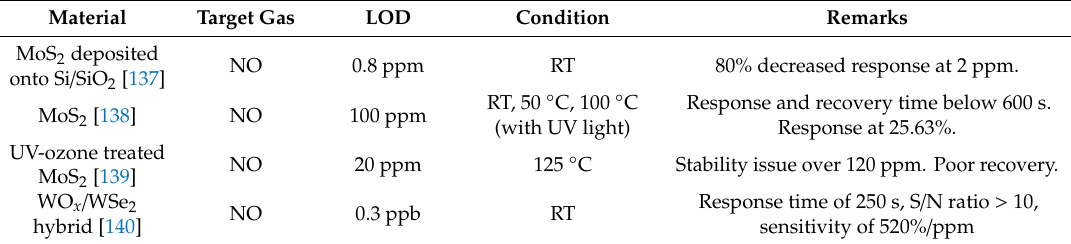
Table 2. NO sensing TMDC materials and their